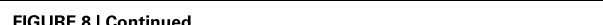
FIGURE 8 | Continued Silencing of Id3 expression or treatment with BMP4 in Tis21 -null SVZ neurosphere cultures rescues their defect of differentiation. (A) Analysis of Id3 protein expression in proliferating C2C12 myoblasts, infected with retroviruses generated by a pSUPER-retro vector expressing the Id3 -specific shRNA sequences sh Id3 -190 and sh Id3 -203 or with a control retrovirus expressing an shRNA targeting luciferase (sh LUC ). After infection, cells were selected for 10 days with G418 and then cultured in proliferating conditions. (B) Representative images of differentiated cells from secondary SVZ neurosphere cultures from 2-month-old wild-type or